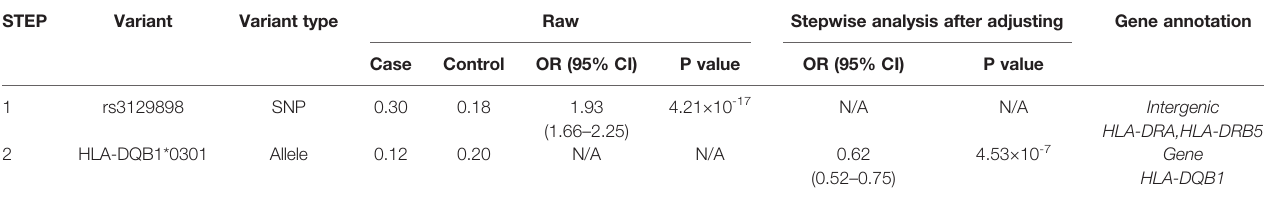
TABLE 2 | Results of stepwise conditional regression analysis of